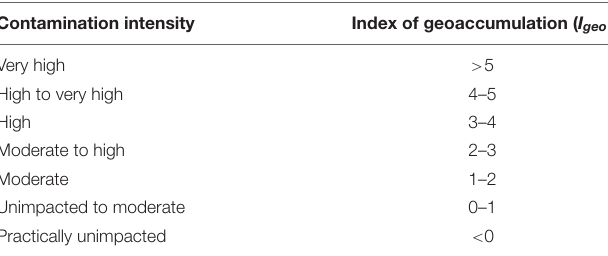
TABLE 1 | Contamination categories based on the index of geoaccumulation ( I geo ), modified from Förstner et al.